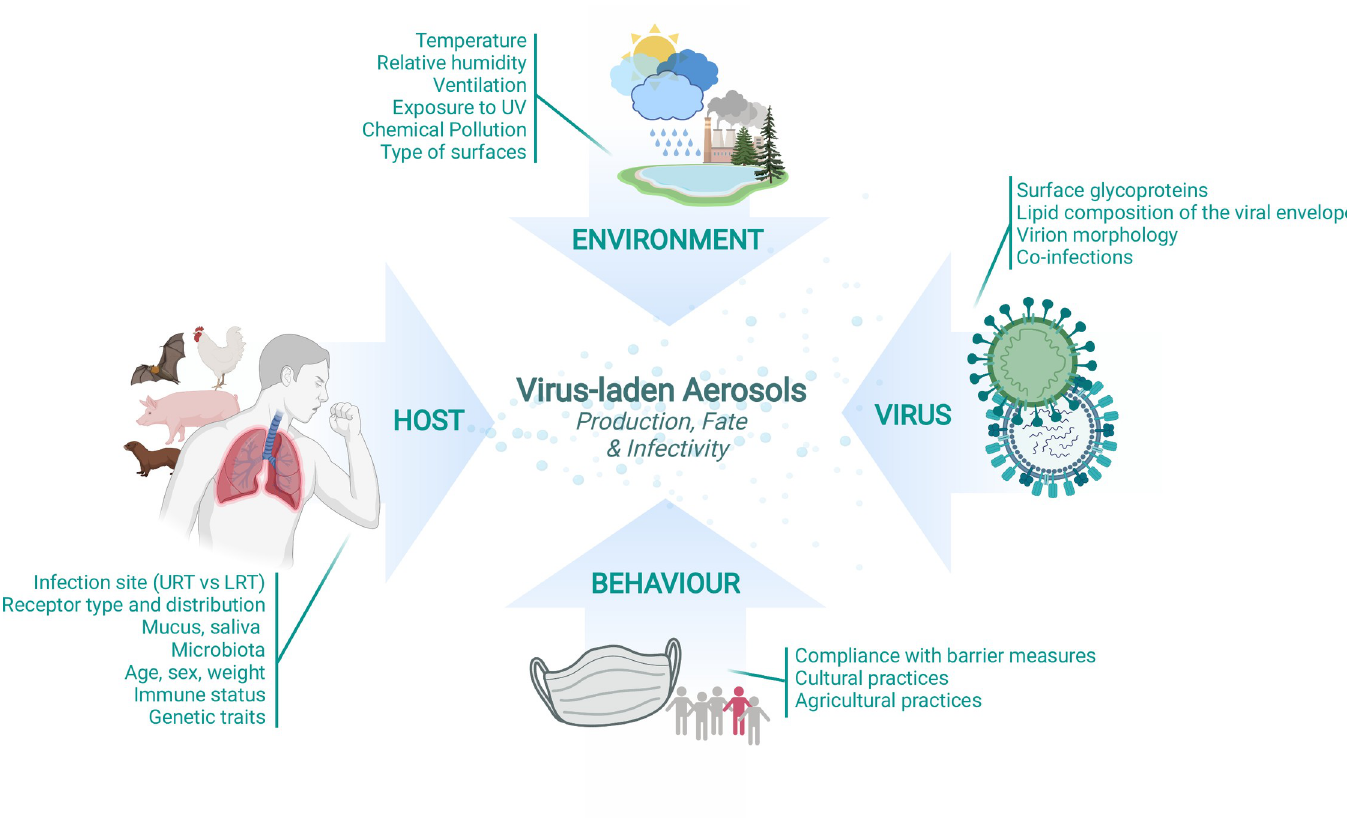
Fig 1. Factors potentially affecting the production, fate, and infectivity of virus-laden aerosols. Only few (mostly environmental and viral factors) have been documented so far. Multidisciplinary progress in this research field will help improve mitigation measures when a new pandemic respiratory virus emerges. Created with BioRender.com. LRT, lower respiratory tract; URT, upper respiratory tract; UV,